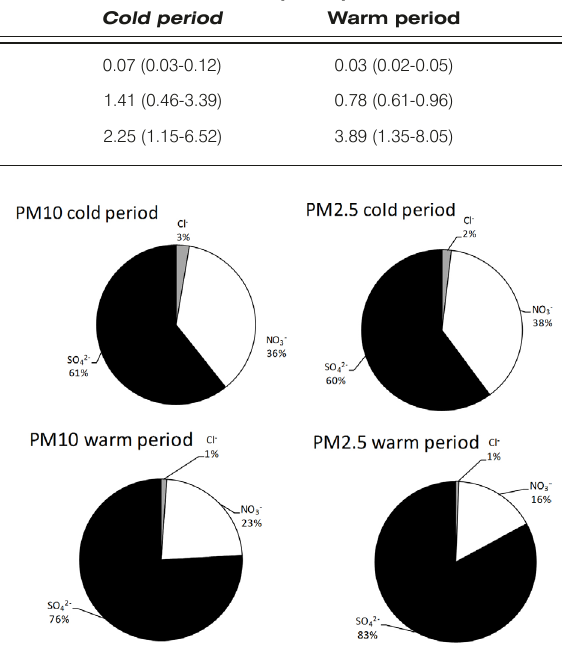
Figure 3. Relative contributions (in %) of anionic species measured in PM 2.5 and PM10 during sampling periods.